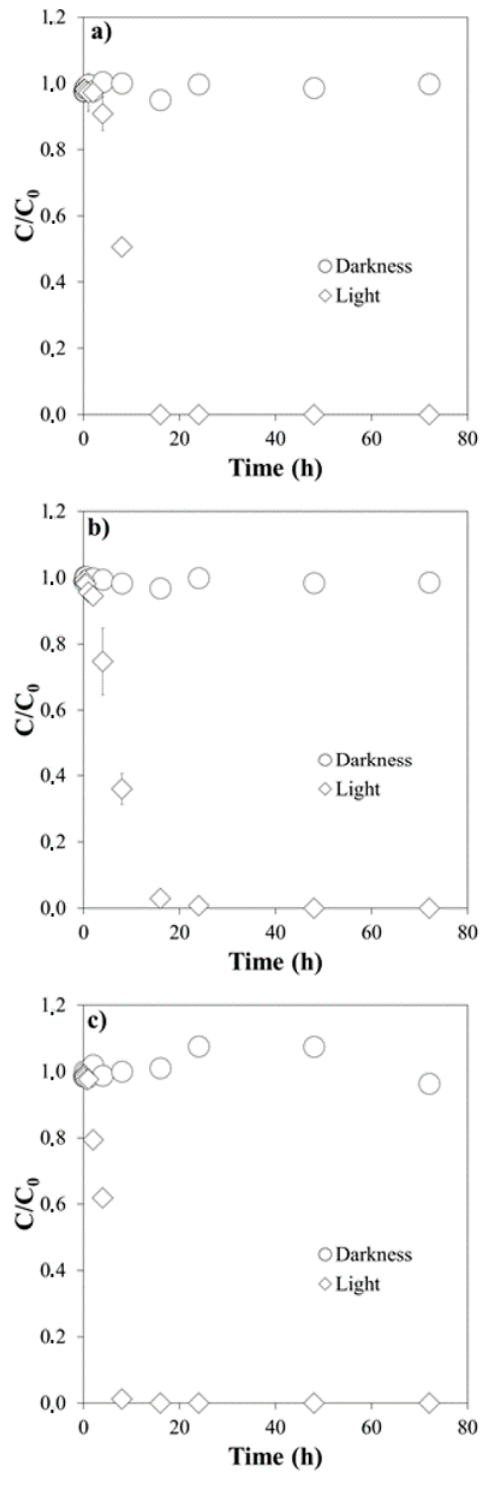
Figure 3. Degradation of Trimethoprim under simulated light and in the dark: ( a ) at pH 4.0; ( b ) at pH 5.5; ( c ) at pH 7.0. C/C 0 is the fraction of the initial concentration ( C 0 ) that remains in the suspension after a given time t.